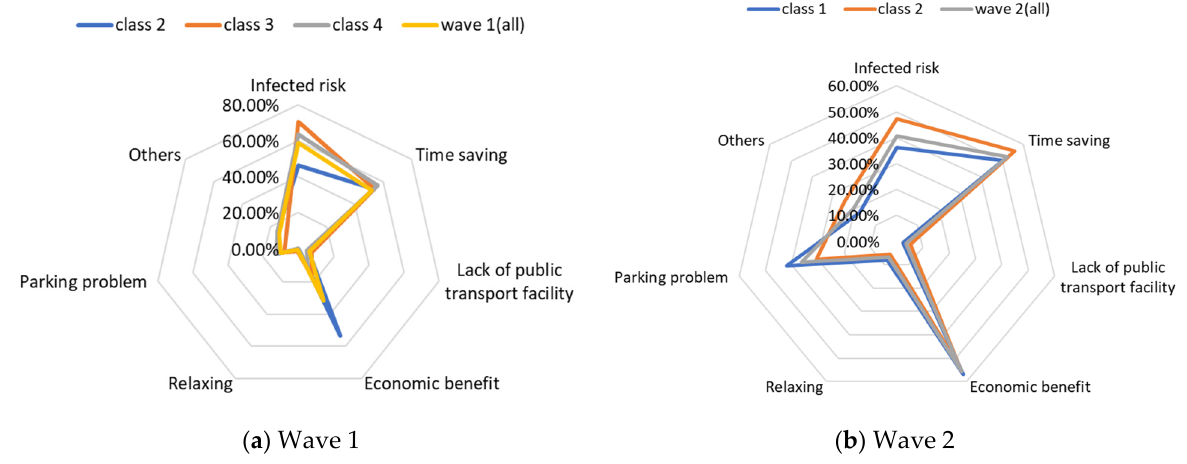
Figure 6. Factors representing the consideration of the two waves in terms of mode choice.